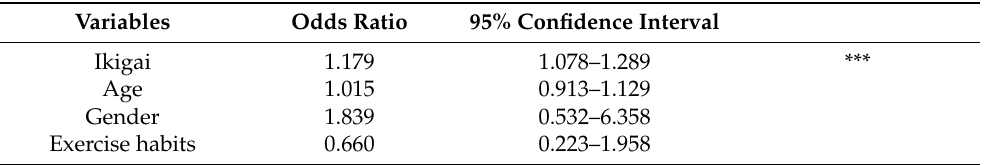
Table 3. Results of logistic regression analysis on high and low life purpose with age, gender, and exercise habits added as variables.